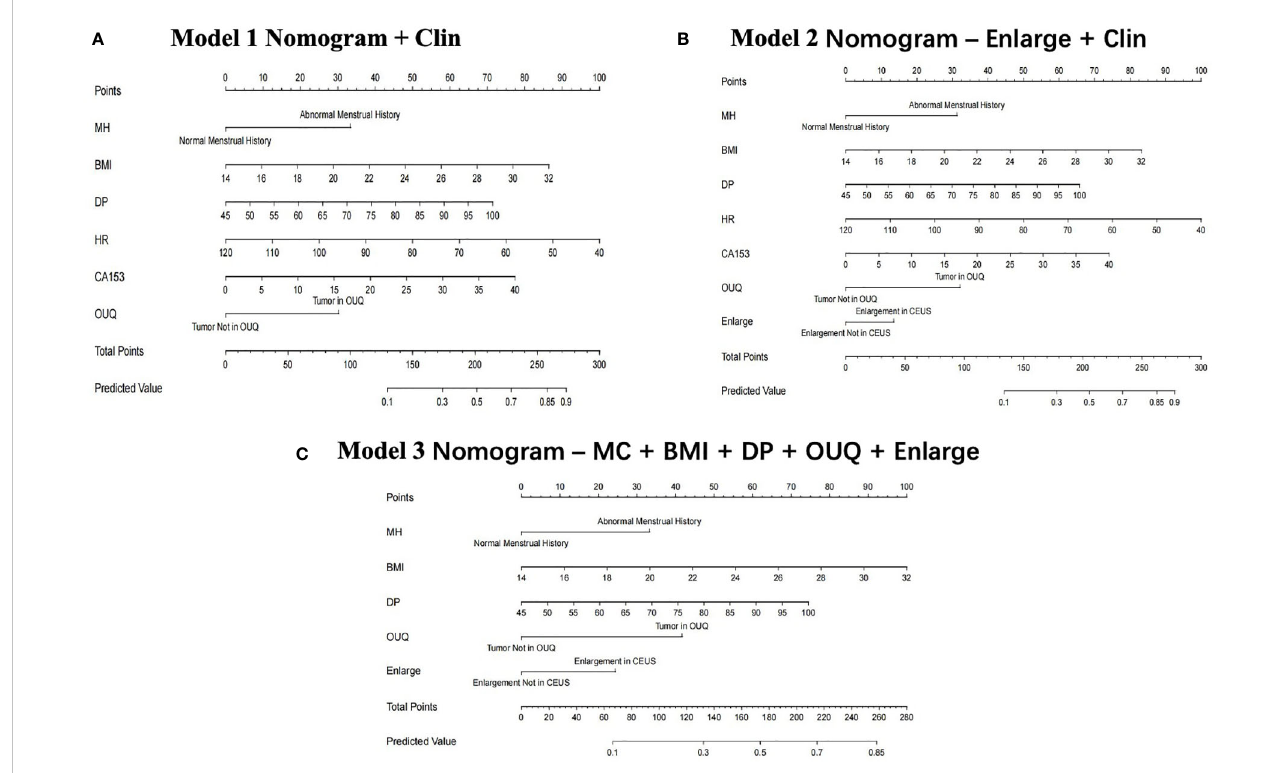
FIGURE 1 Clin, clinical features; MC, menstrual cycle; BMI, body mass index; DP, diastolic pressure; OUQ, outer upper quarter. Nomogram graphics of Clin model (A) , Enlarge + Clin model (B) and MC+BMI+ DP+ OUQ+ Enlarge model (C) for predicting Her-2 over-expression